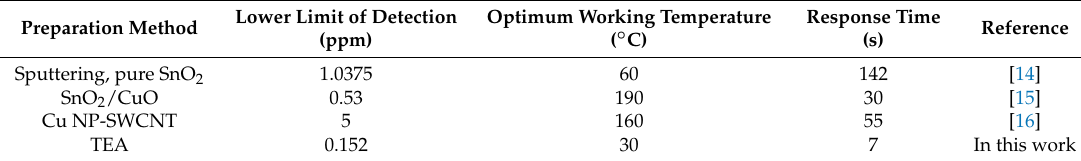
Table 2. The comparison of the proposed SAW H 2 S Sensor with existing sensor